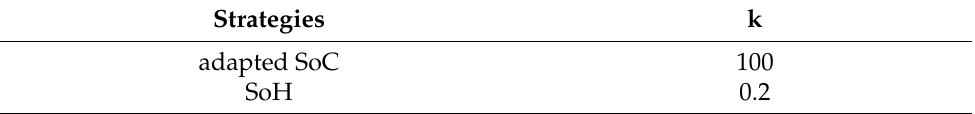
Table 3. Gain of the control strategies.